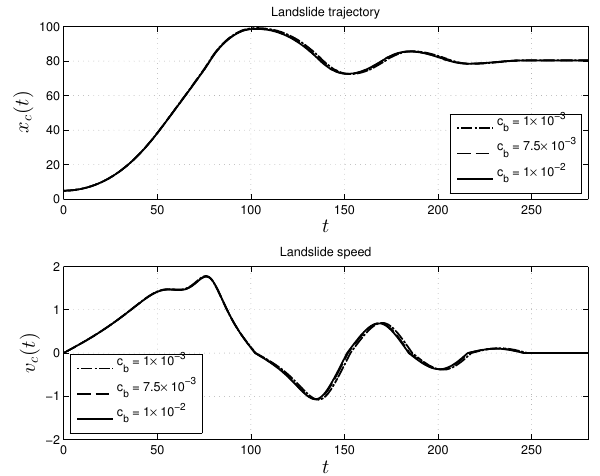
Figure 3. Velocity and acceleration of the barycenter of the landslide as a func- Fig. 3. Velocity and acceleration of the barycenter of the land- Figure 5. Position and velocity of the barycenter of the landslide as functions of tion of dimensional time. The friction coefficient is c f = tan(3 ◦ ) . The slide as a function of dimensional time. The friction coefficient is Fig. 5. Position and velocity of the barycenter of the landslide as d s discontinuities in the acceleration are due to the coefficient sign dimensional time for three different values of the friction coefficient c f = tan ( 3 ◦ ) . The discontinuities in the acceleration are due to the functions of dimensional time for three different values of the fric- d t (cid:1) in the definition of the friction force. D. Dutykh & H. Kalisch 8 / 33 in the definition of the friction force. c b . coefficient sign (cid:0) d s tion coefficient c b (cid:1) (cid:0) d t